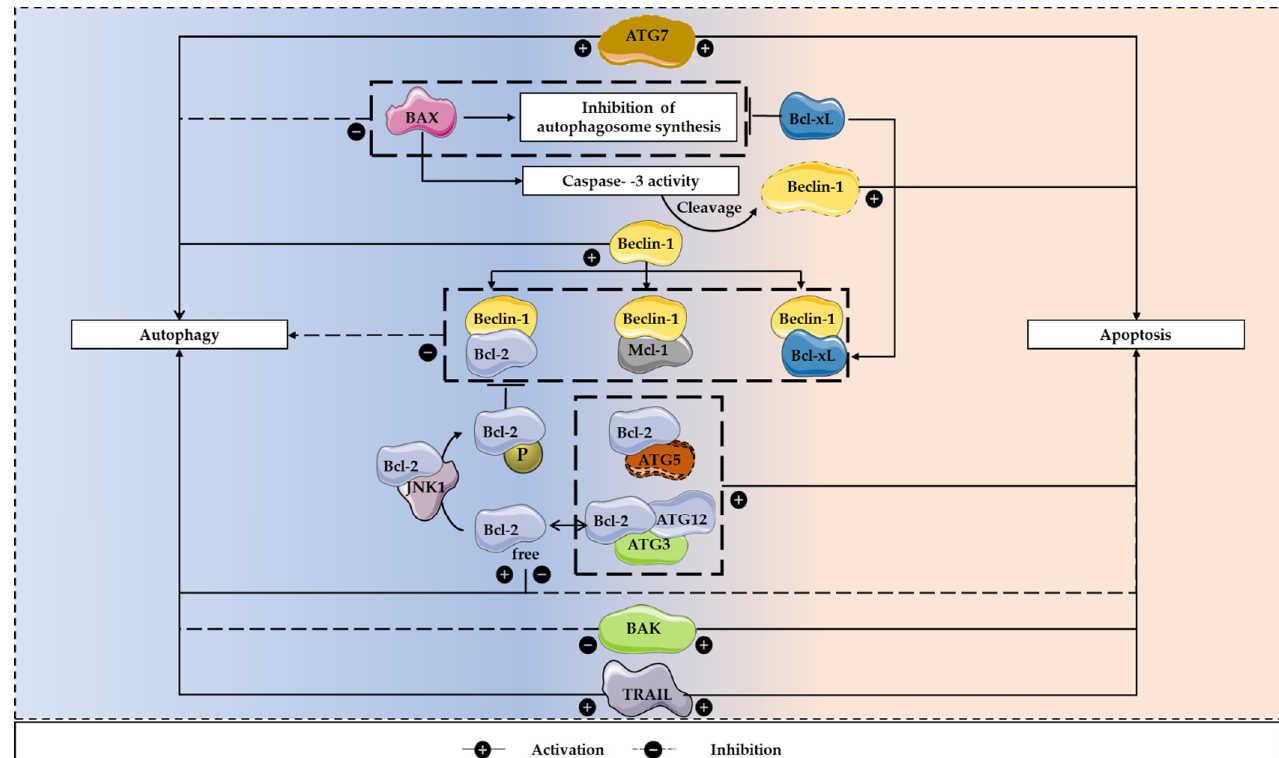
Figure 4. The apoptosis/autophagy regulation loop. There are several apoptosis regulators that are also involved in the control of autophagy and both processes are often activated together to respond to stress stimuli. These interactions can result in both inhibition and induction of autophagy. To inhibit the autophagic process, Beclin-1 can bind to Bcl-2, Bcl-xL and Mcl-1. In contrast, under nutrient starvation conditions, Bcl-2 is prevented in binding to Beclin-1, after being phosphorylated by JNK1, allowing the initiation of autophagosomes formation. Furthermore, BAX can lead to Beclin-1 cleavage, which is dependent on caspase-3 activity. This pro-apoptotic protein can also inhibit the autophagosome synthesis, a process that can be reverted by Bcl-xL. In addition, activators of apoptosis, including TRAIL, can regulate autophagy, having a positive influence on this mechanism. Regarding apoptosis induction, calpain-cleaved ATG5 and Bcl-2 interaction facilitates this programmed cell death process. Moreover, ATG7 expression leads to autophagy induction, caspase activation and increased cell death. The conjugation ATG12-ATG3 can also regulate apoptosis, as its disruption may result in increased Bcl-2 expression and decreased apoptotic cell